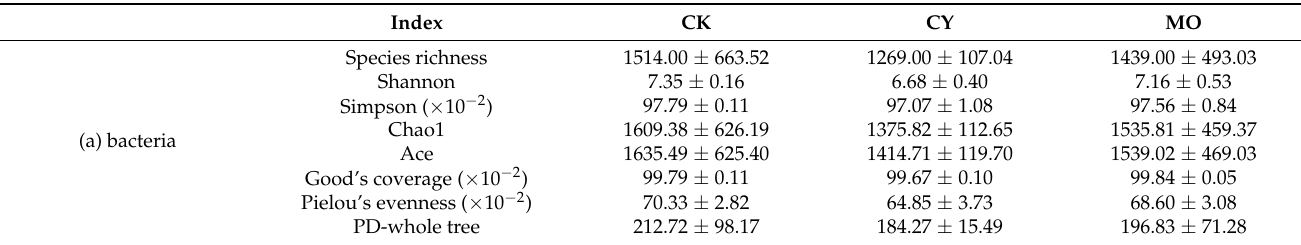
Table 3. Descriptive analysis and difference significance test of alpha diversity for each group.